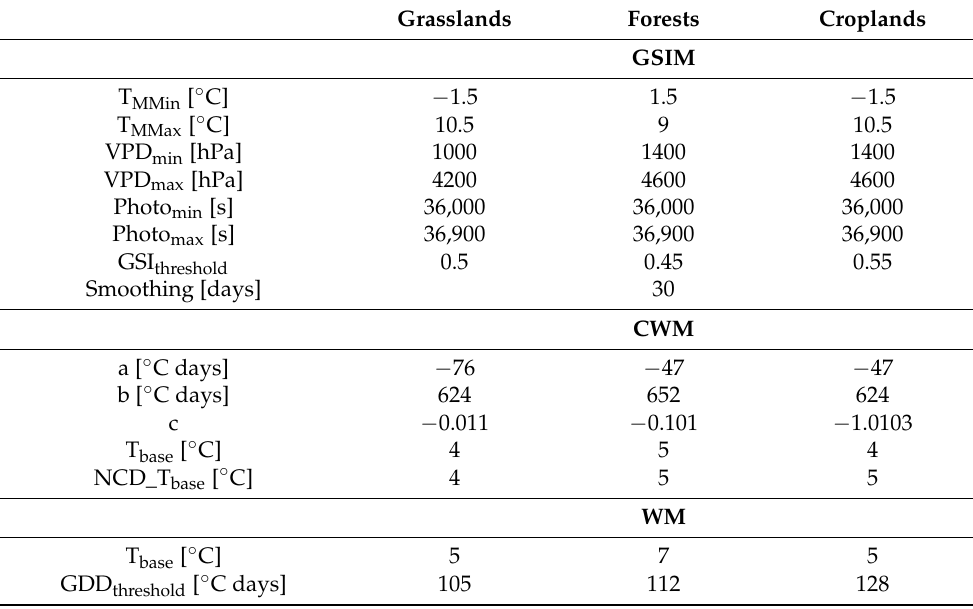
Table 1. PFT-specific parameters for the three optimised models used in the study. WM refers to the warming model, CWM stands for the chilling-warming model, and GSIM is the Growing Season Index Model. A detailed description of the GSIM is provided in